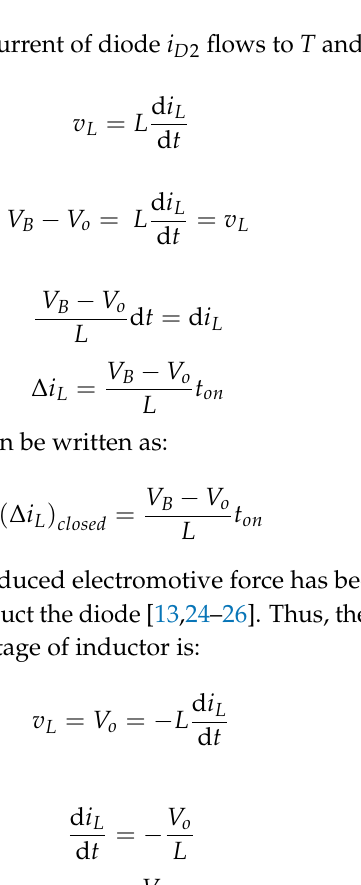
Figure 3. Equivalent circuit model of the TE Board power generation system.